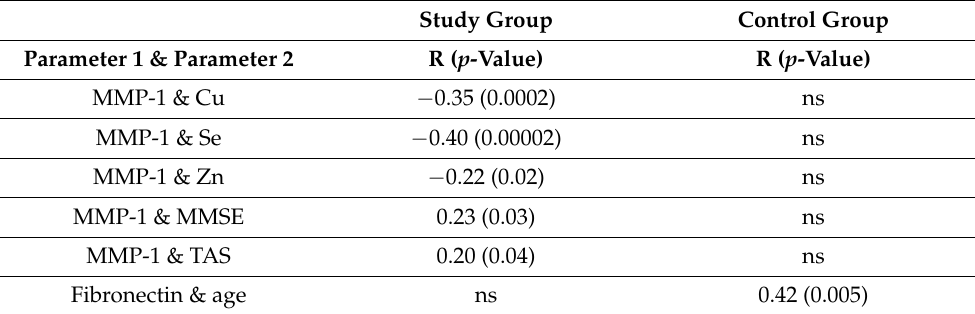
Table 3. Significant correlations between the studied parameters in the control group and the study